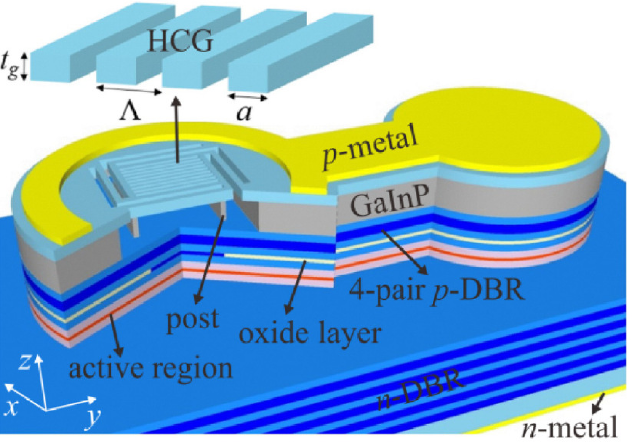
Figure 20. Schematic diagram of the structure. Basic structure of the tunable LC-VSCEL the same as the HCG liquid crystal laser control structure are displayed [101]. Reprinted with permission from Ref. [101]. 2022 The Optical Society.